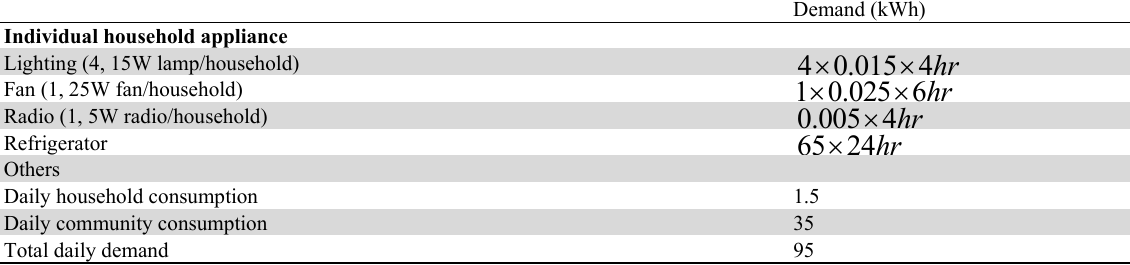
Typical community electricity needs for 40